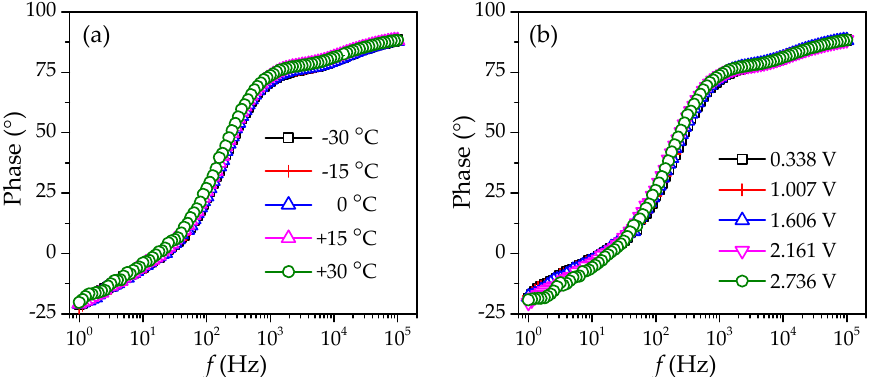
Figure 4. Phase ( θ ) of Z as a function of frequency ( a ) at different temperatures for constant voltage (~2.5 V) and ( b ) at different voltages for a constant temperature of 15 °C.